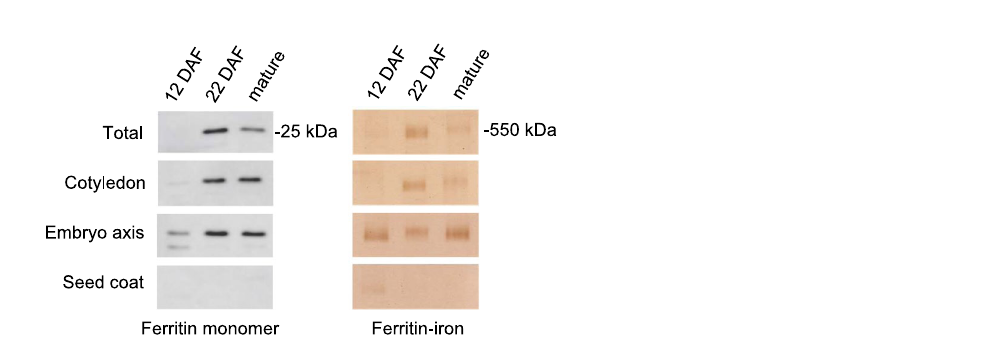
Figure 1. Ferritin protein and iron loading during development of pea seeds. ( A ) Images of opened seed pods at the indicated days after flowering (DAF). ( B ) Protein blot analysis of ferritin in extracts from pea seeds. A dilution series of purified pea ferritin (40 − 5 ng) was run in the four left lanes for comparison with pea extracts (5 µ g protein per lane). ( C ) Iron staining associated with assembled ferritin shells. A dilution series of freshly purified pea ferritin (250–62.5 ng protein, or 55 – 14 ng Fe) and protein extracts from developing peas (20 µ g protein per lane) were separated by native gel electrophoresis and stained for iron with Perls’ staining and diaminobenzidine enhancement. The data shown are representative of 4 independent time courses. A second data set is shown in Figure S2.